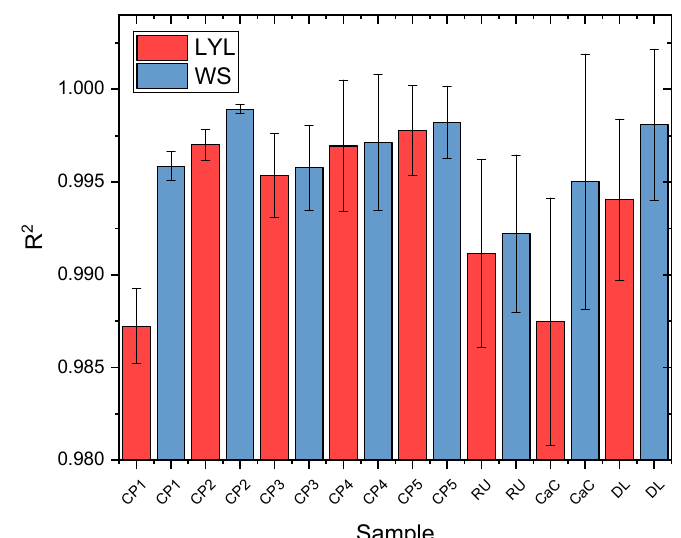
Figure 9. R 2 values for the investigated samples.